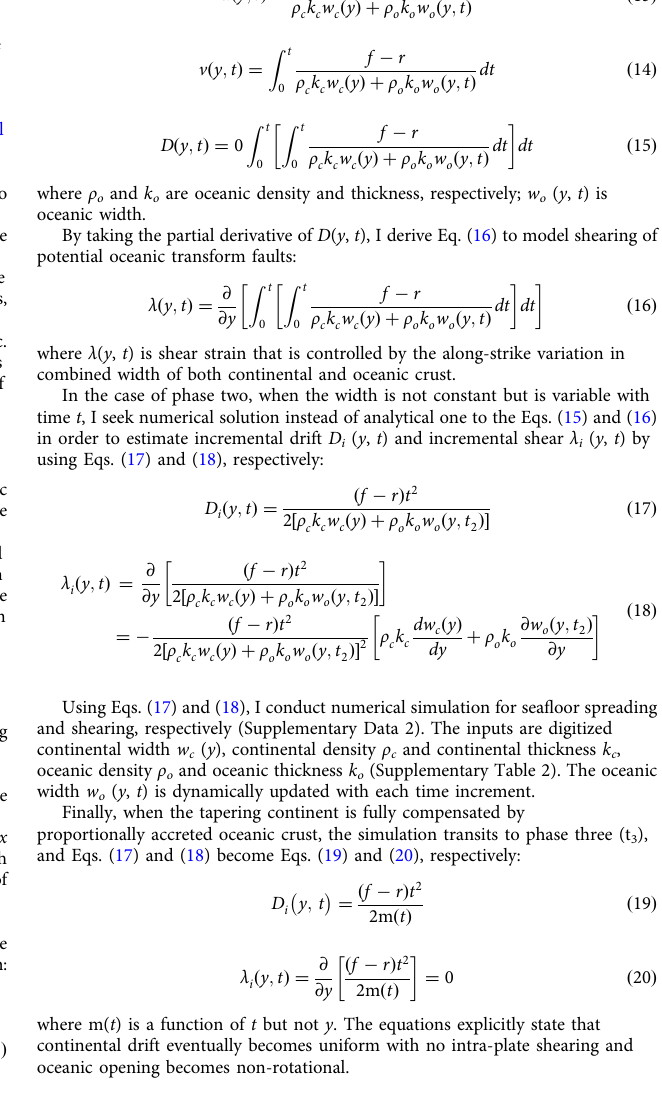
Fig. 7 Depth pro fi les across and along the axis of the Mid-Atlantic Ridge. See Fig. 4 for locations. a Depth pro fi le across the axis of the Mid-Atlantic Ridge showing asymmetric Atlantic Ocean and Mid-Atlantic Ridge. b Depth pro fi le 31 along the axis of the Mid-Atlantic Ridge showing asymmetric axial